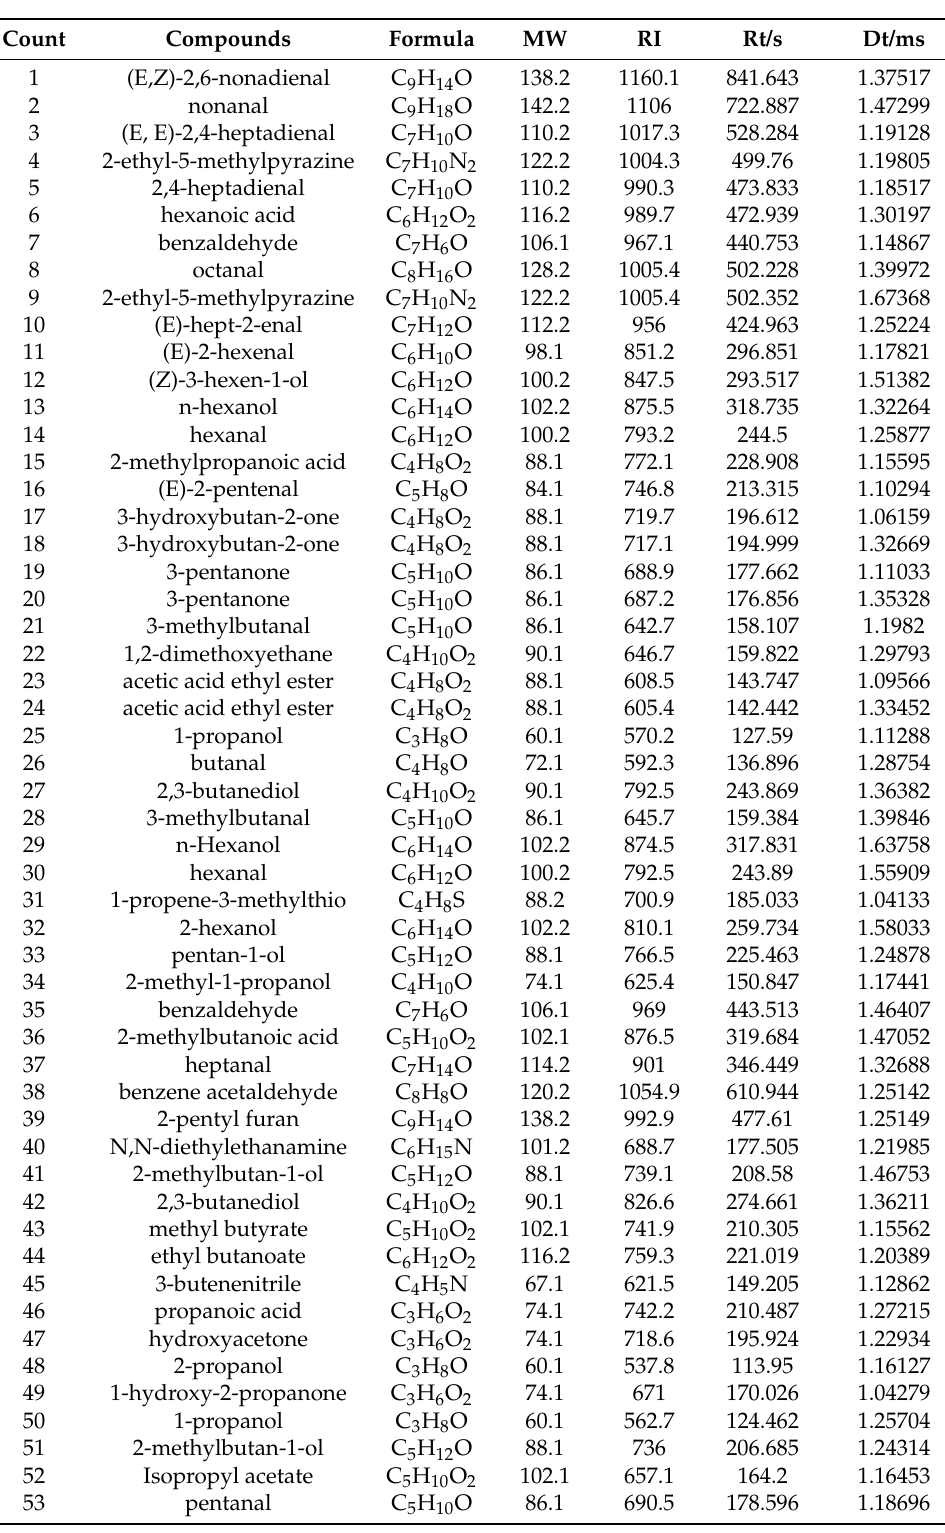
Table 2. Qualitative information of volatile organic compounds in cucumbers under different treatments CS20+P; CS40+P; CS60+P; and NCS+P. CS20+P − packaged after 20 min of cold shock; CS40+P − packaged after 40 min of cold shock; CS60+P − packaged after 60 min of cold shock; NCS+P − packaged after 0 min of cold